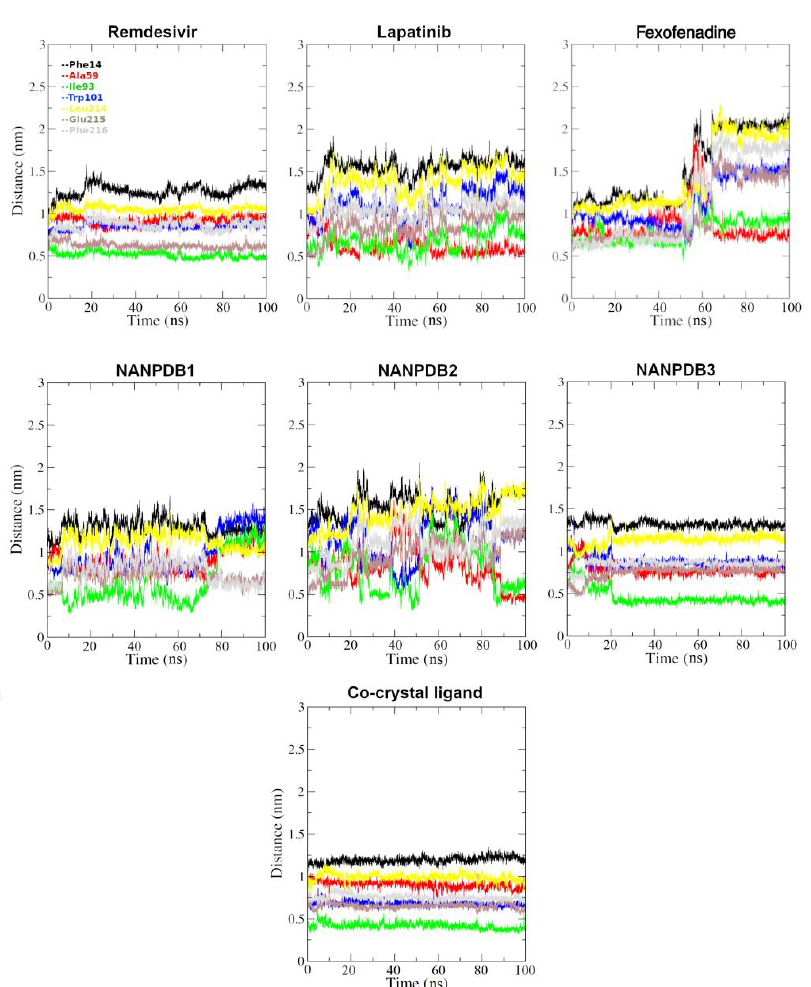
Figure 8. The distance between the center of mass of the indicated ligand and residues of Fascin protein in the binding site under investigation during a 100 ns (100,000 ps) MD simulation.